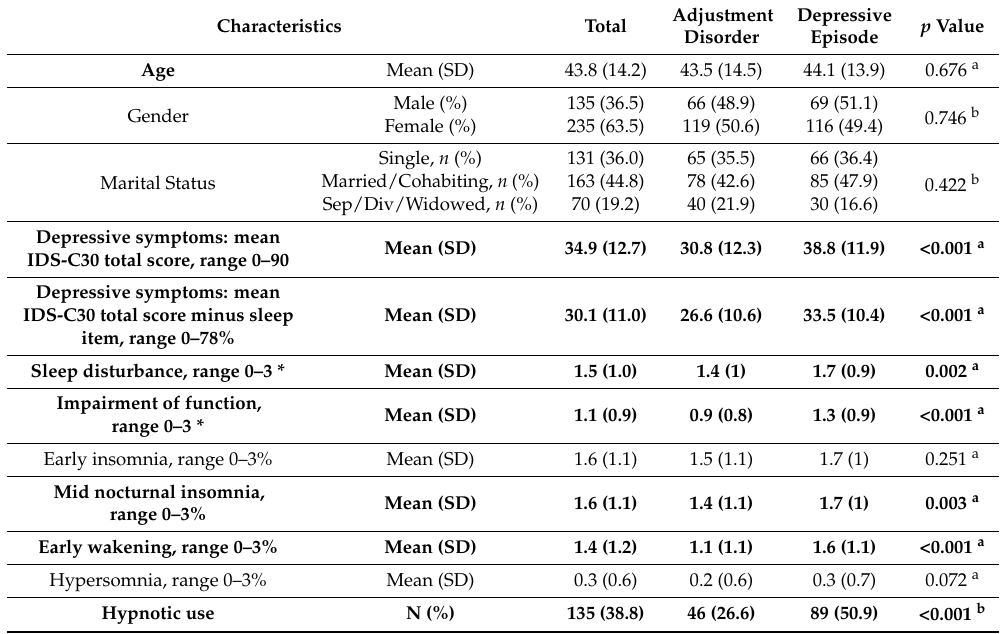
Table 1. Demographic and clinical characteristics of patients divided by